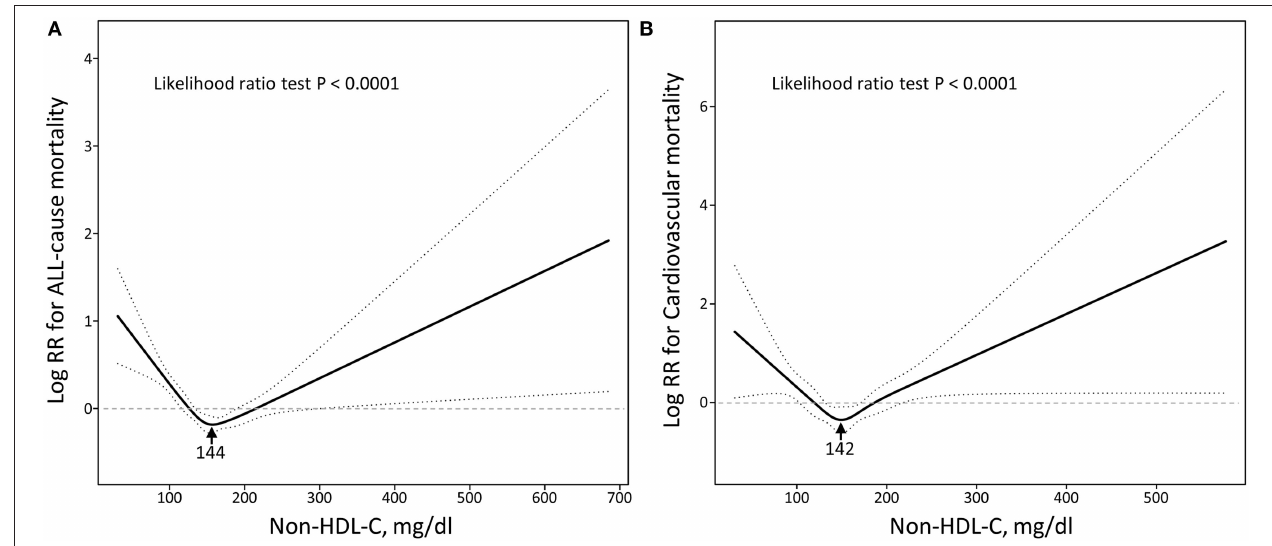
FIGURE 3 | Restricted cubic spine models of non-HDL-C with all-cause (A) and cardiovascular (B) mortality. Non-HDL-C, non-high-density lipoprotein cholesterol. Restricted cubic spine models were adjusted for adjusted for age, race, education, body mass index, systolic blood pressure, diastolic blood pressure, smoking, diabetes, hypertension, coronary heart disease, stroke, creatinine, haemoglobin, glycated haemoglobin A1c, triglycerides, energy intake, protein intake, carbohydrate intake, and total fat intake.